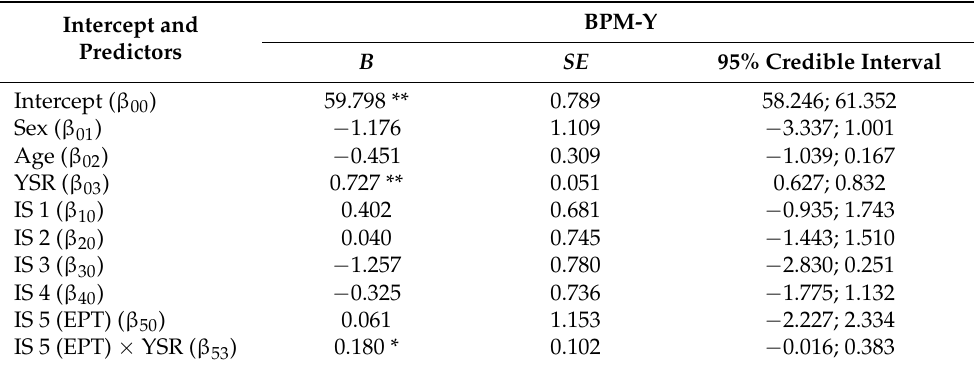
Table 2. Effect of IS on BPM-Y.